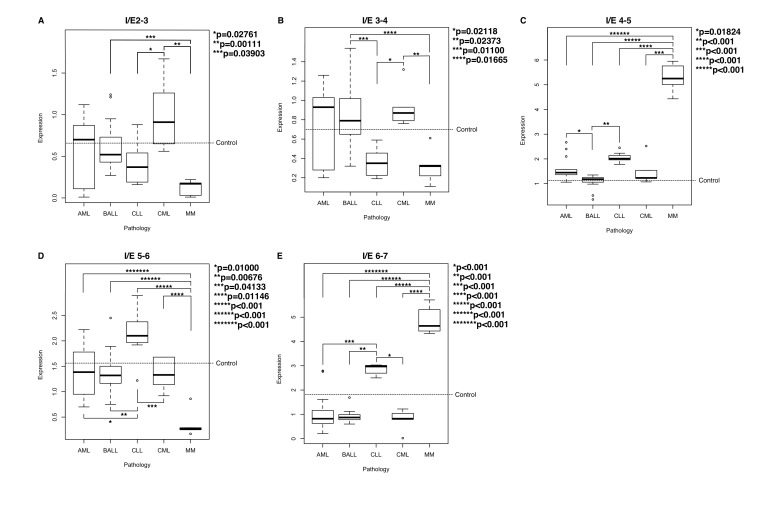
Level of expression of every interexon (I/E) in the assessed pathologies.(A) expression of the interexon 2-3, (B) expression of the interexon 3-4, (C) expression of interexon 4-5, (D) expression of the inter-exon 56 and (E) expression of interexon 6-7. CML (chronic myeloid leukemia), MM (multiple myeloma), CLL (chronic lymphoid leukemia), BALL ( B acute Lymphoblastic leukemia), AML (acute myeloid leukemia). The control line is the arithmetic media (s.d. <0,01 in all PCR) of three healthy peripherial Blood controls.